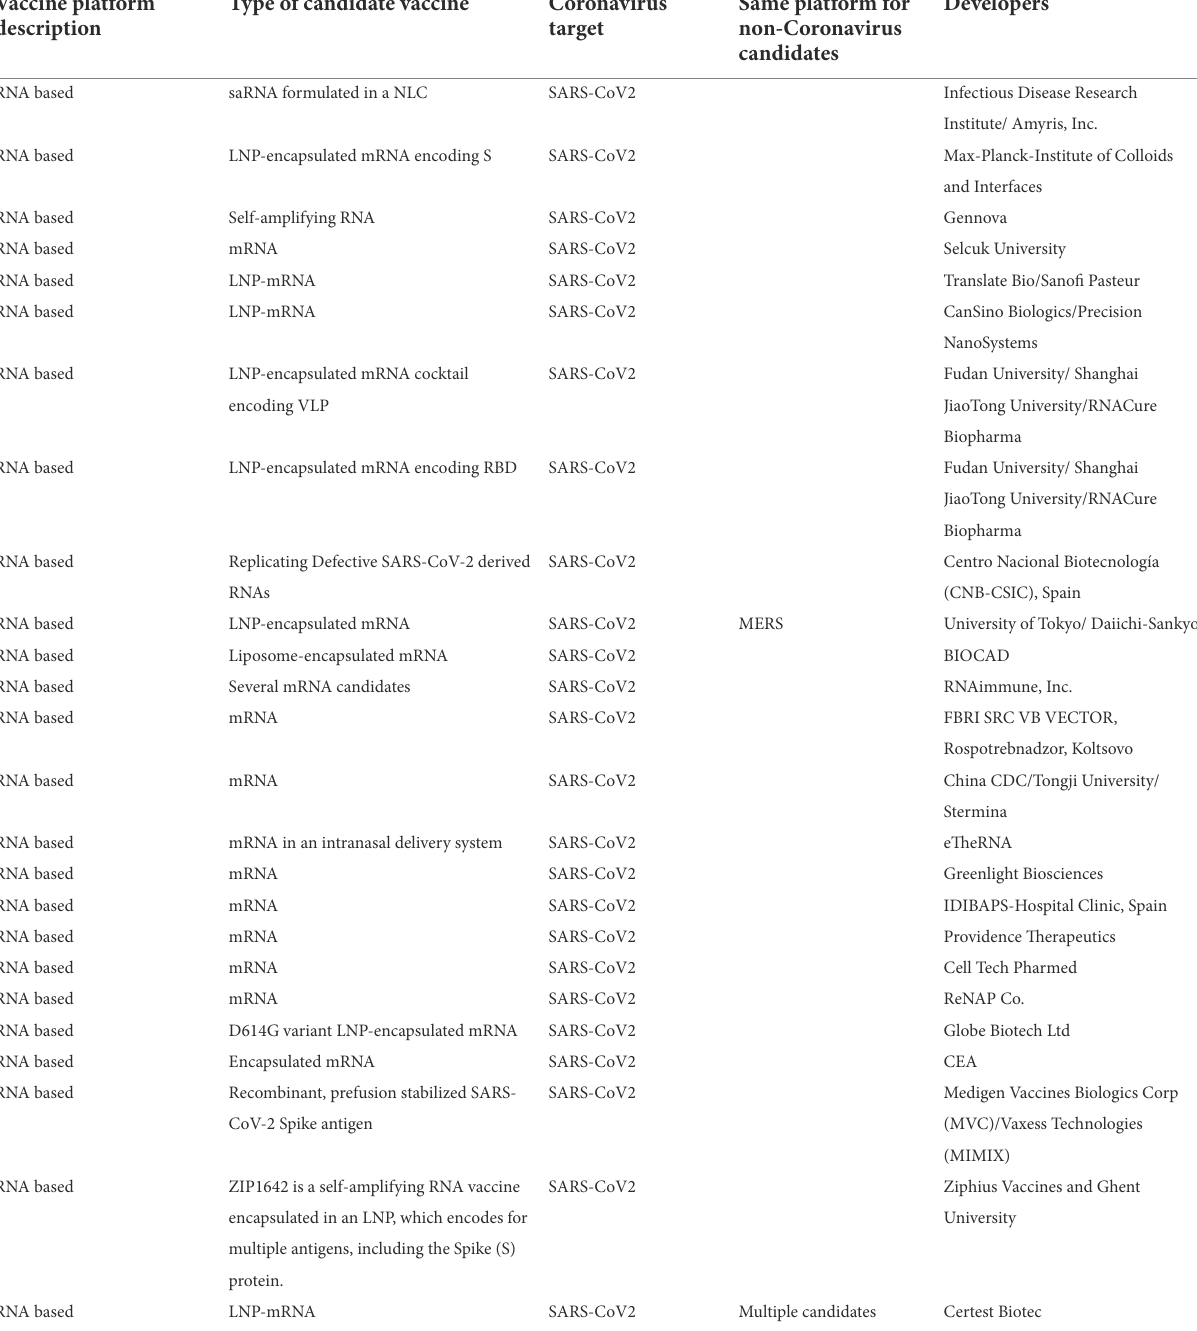
TABLE 2 Preclinical study of A COVID-19 mRNA vaccine (from https://www.who.int/publications/m/item/draft-landscape-of-covid-19-candidate- vaccines, 30 August 2022). Vaccine platform